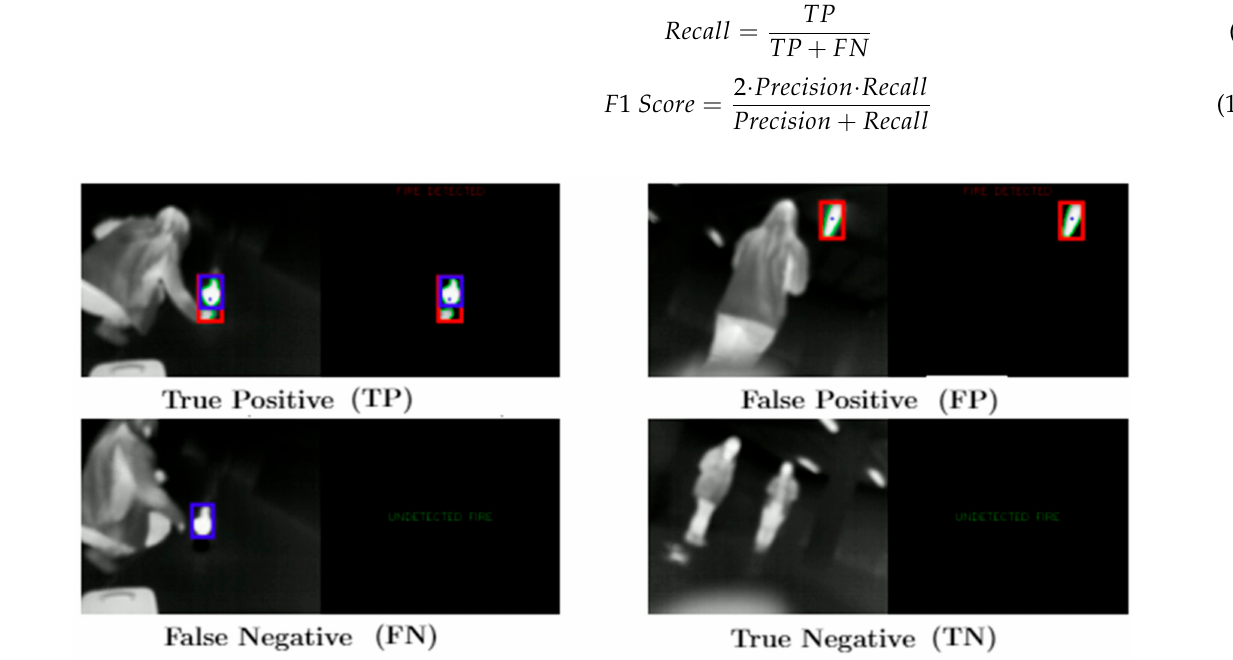
Figure 6. Definitions of TP, FP, FN, and TN.